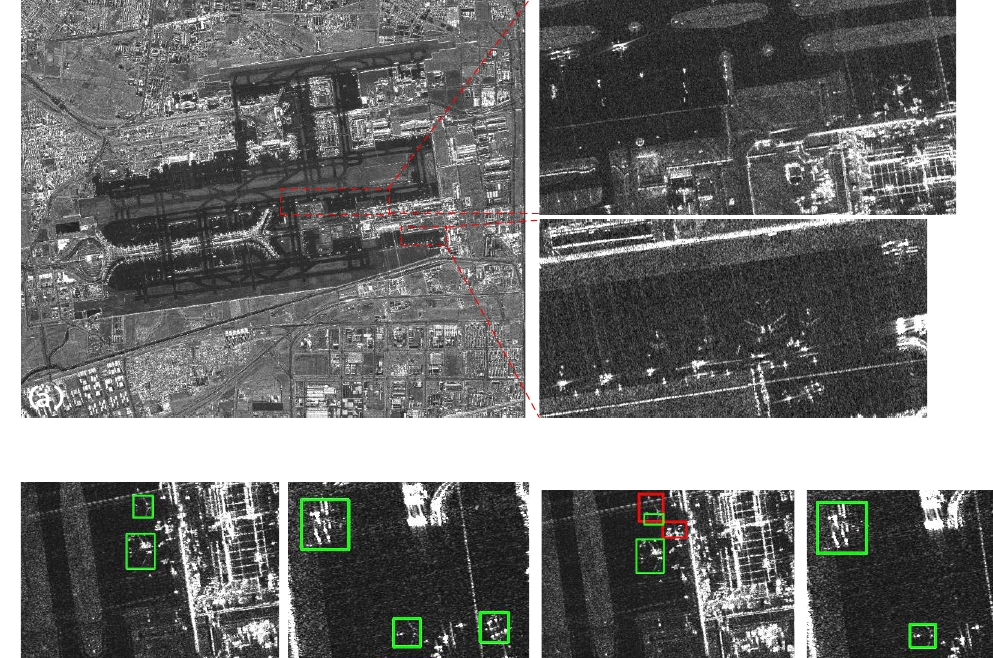
14 Table 6. Results of different network on our validation dataset. Network